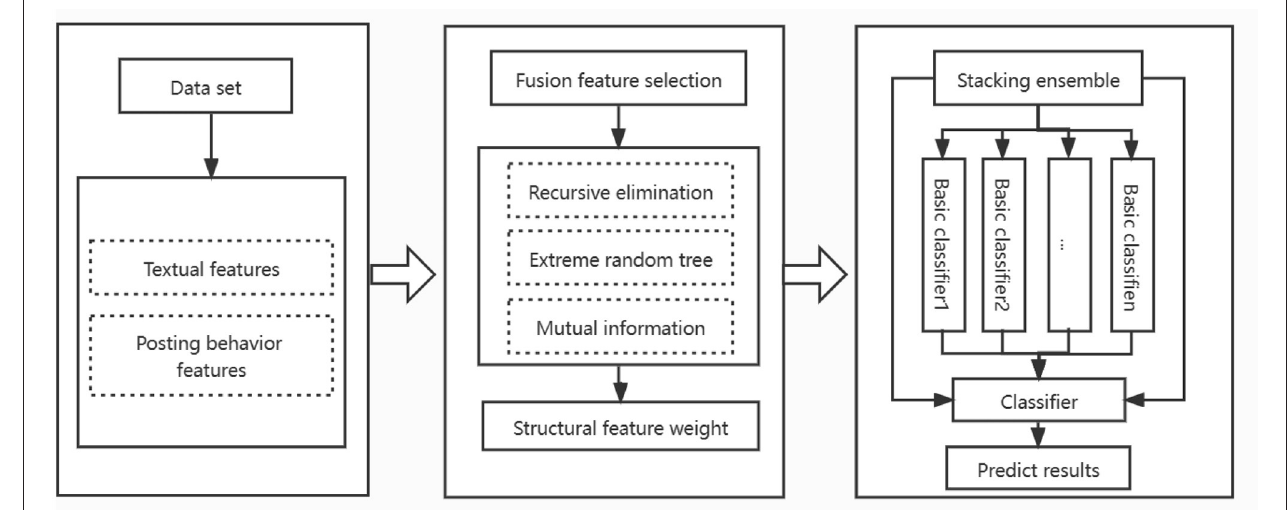
FIGURE 2 | Depression user identification